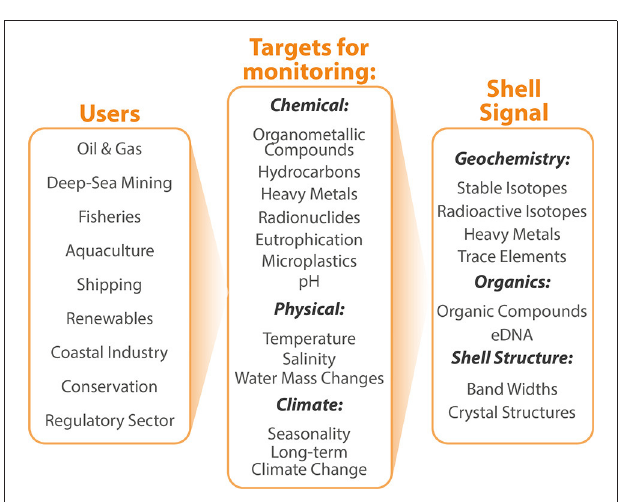
FIGURE 11 | Summary of potential users, monitoring targets and shell signals that can make use of bivalve